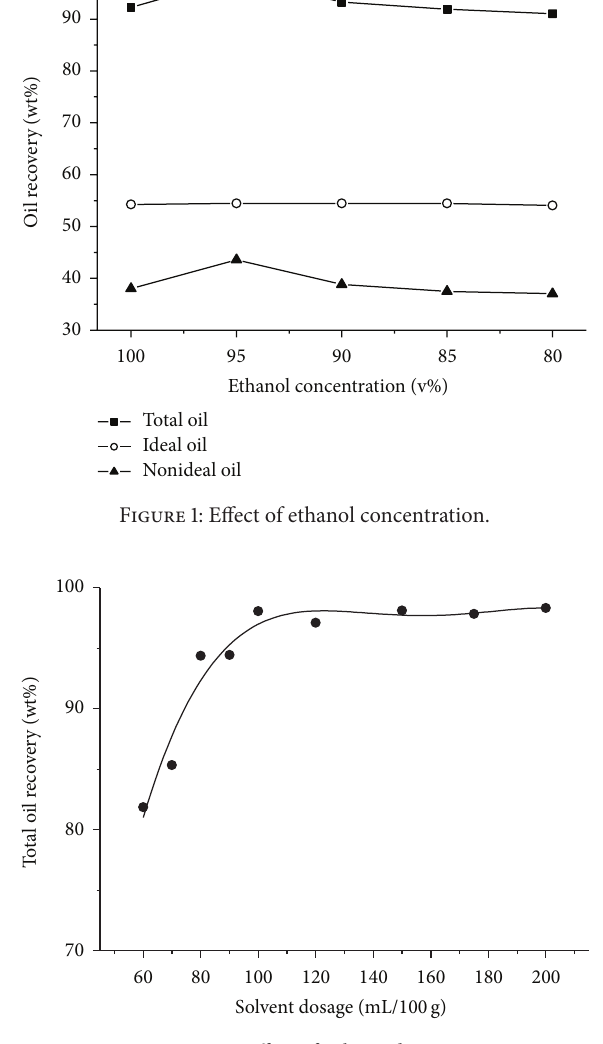
Figure 2: Effect of solvent dosage.